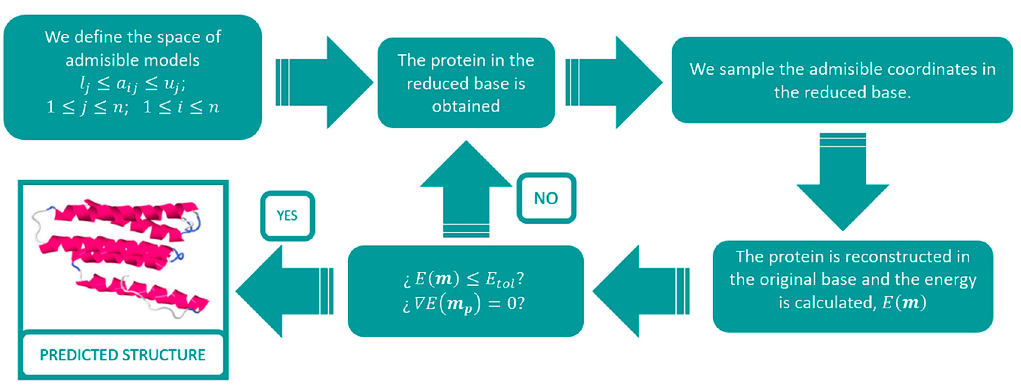
Figure 2. Overview of the protein modelling via regressive–regressive particle swarm optimization (RR-PSO).